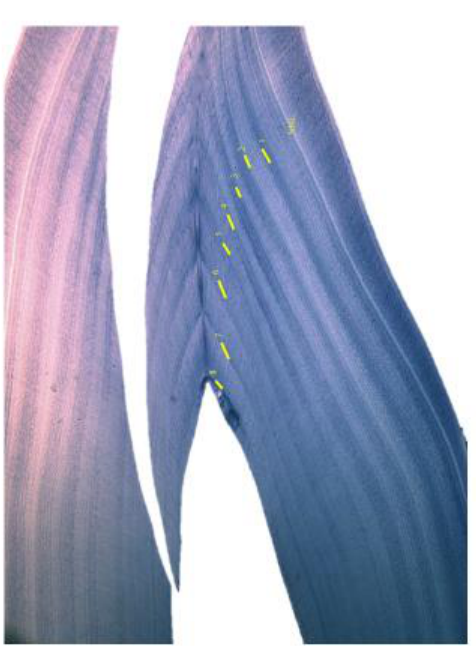
Fig. 2b. Dentinal growth layers identified in stained section of bottlenose dolphin ( Tursiops Truncatus ) age 16 years. NNL is the neonatal line. Manatees ( Trichechus manatus ) and dugongs ( Dugong dugong ),